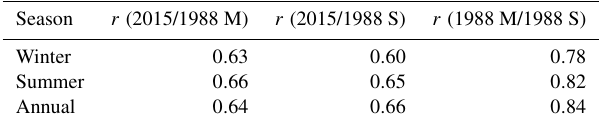
Table 2. Correlation coefficients ( r ) calculated for different combi- nations of δ 18 O records for the period 1801–1987 ( p < 0 . 05).